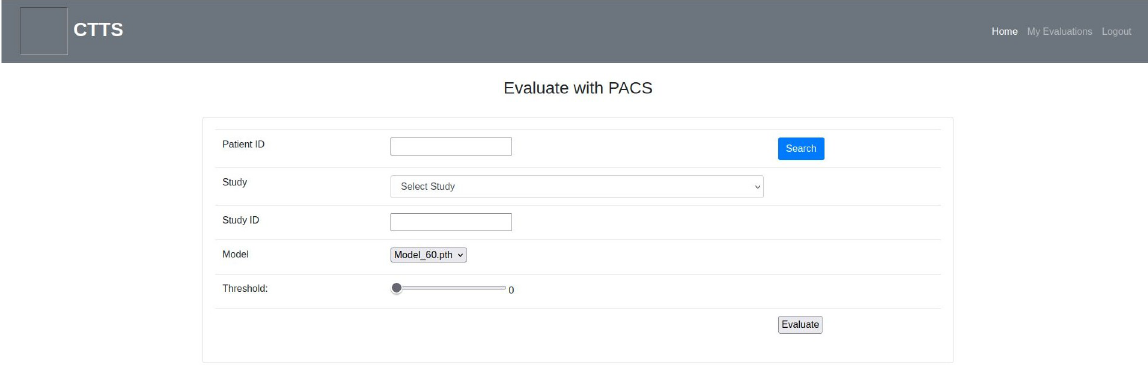
Fig 7. Evaluate with PACS